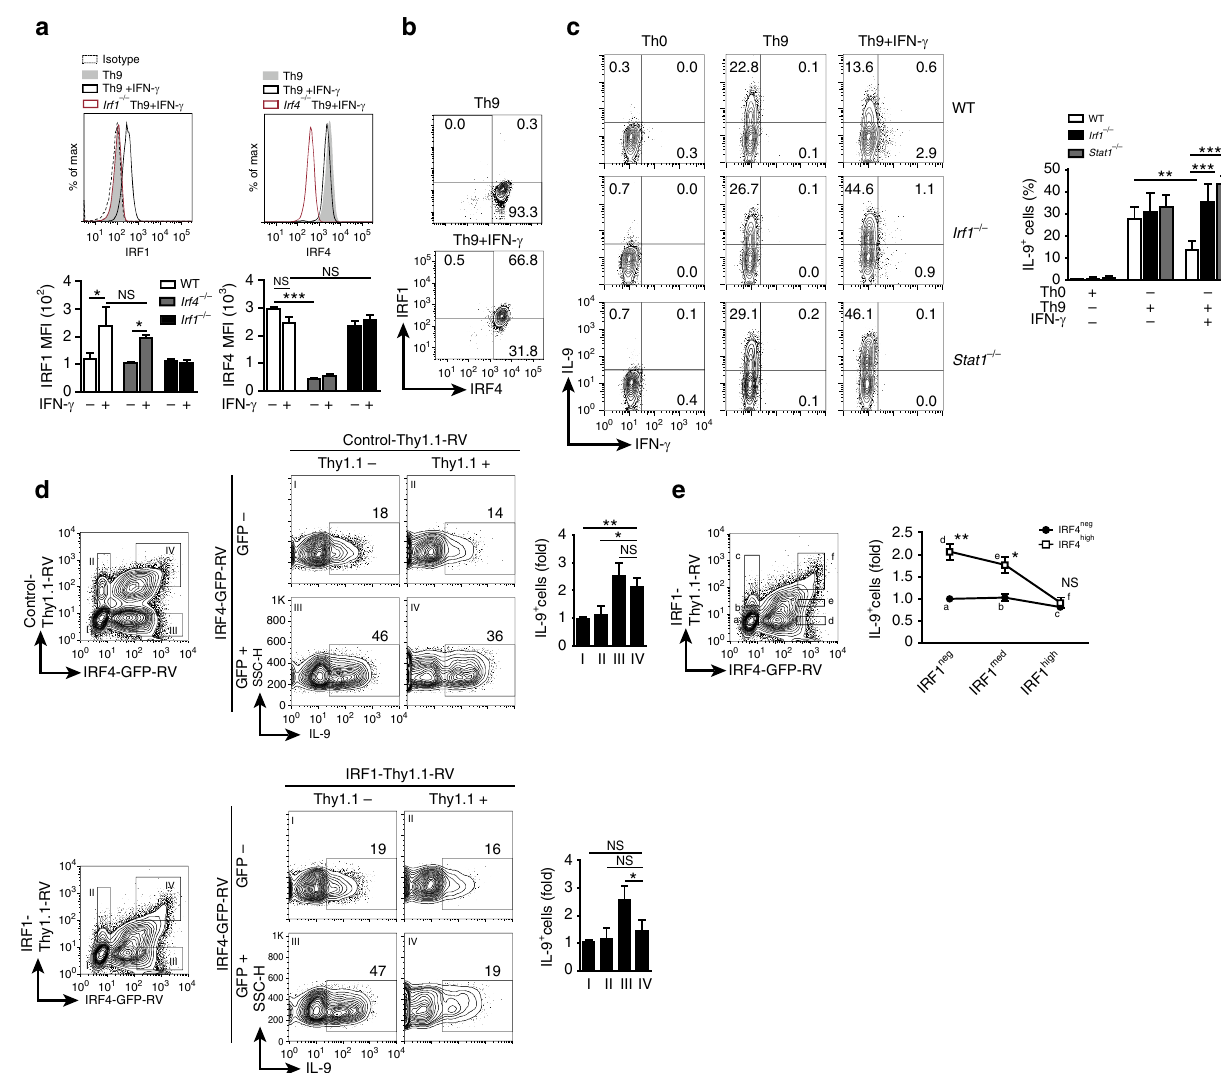
Figure 1 | IRF1 limits IRF4-driven IL-9 production dose-dependently. ( a – c ) Naive CD44 (cid:2) CD62L þ CD4 þ T cells were isolated from WT, Irf4 (cid:2) / (cid:2) , Irf1 (cid:2) / (cid:2) or Stat1 (cid:2) / (cid:2) mice and then treated under Th9 (TGF- b and IL-4) or Th0 (without skewing cytokines) conditions with/without IFN- g as indicated. ( a , b ) After resting and reculture under Th9 conditions for 2 days, intracellular flow cytometric analysis for IRF1 and IRF4 were performed. Bars give geometric mean of fluorescence intensity (MFI). ( c ) Cells were restimulated and then IL-9 and IFN- g production was detected by flow cytometry, bars to the right give mean of IL-9 þ T cells. ( d , e ) Irf4 (cid:2) / (cid:2) CD4 þ T cells were isolated, activated under Th0 condition overnight and then spin-infected with retroviruses as indicated: IRF4-GFP-RV, control-Thy1.1-RV, and IRF1-Thy1.1-RV. Thereafter, cells were cultured under Th9 conditions for 2 days, rested for 3 days and recultured under Th9 conditions for additional 2 days. Four subsets (I–IV) were selected for analysis of IL-9 production. Bars to the right show fold induction of IL-9 þ T cells relative to GFP (cid:2) Thy.1.1 (cid:2) cells (subset I). ( e ) Six subsets (a through f) expressing increasing levels of GFP and Thy1.1 were selected for analysis of IL-9 production (left panel). Dot plot to the left is representative for four independent experiments. Graph to the right shows fold induction of IL-9 þ T cells relative to GFP (cid:2) Thy1.1 (cid:2) cells (subset a) combined from four independent experiments. Histogram and contour-plots are representative of two ( a , b ), three ( c ) or four ( d , e ) independent experiments. Bars show mean ± s.d. from combined two ( a , b ), three ( c ) or four ( d , e